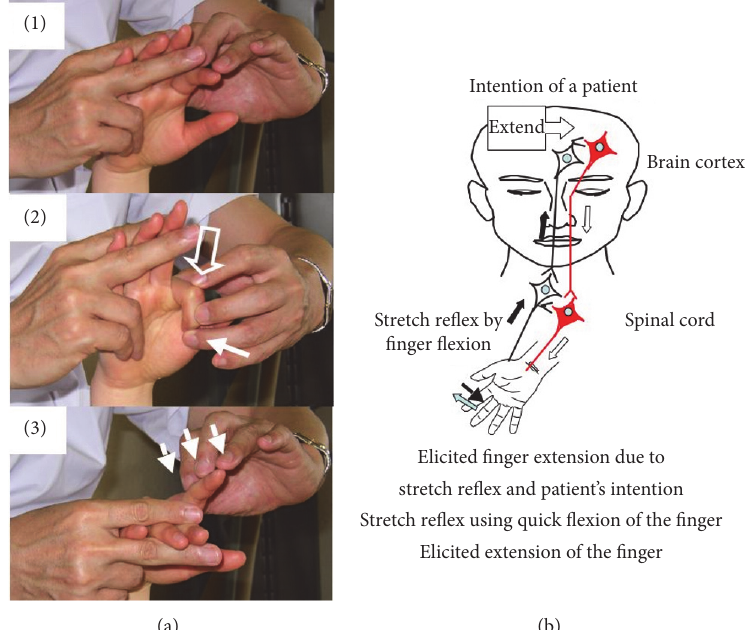
Figure 3: Hypothesized mechanism of a newly designed facilitation exercise for the hemiplegic upper limb and fingers. (a) Facilitation for extension of the isolated finger is performed as follows: (1) the finger is quickly flexed by the therapist; this elicits the stretch reflex; (2) the therapist instructs, “Extend” and pushes the proximal phalanx to flex the metacarpophalangeal (MP); and (3) the therapist applies slight resistance against finger extension to maintain extension of the finger. The thick arrow and thin arrow indicate manipulation to induce the stretch reflex and light touch (resistance) to maintain the 𝛼 - 𝛾 linkage, respectively. (b) Descending motor tracts related to the patient’s intention to move will respond to excitation of the patient’s intention when these neural tracts are excited to a sufficient excitation level by facilitation techniques and result in the realization of movements by the patient’s intention. Modified from Figure 1 in Kawahira et al. (2010).